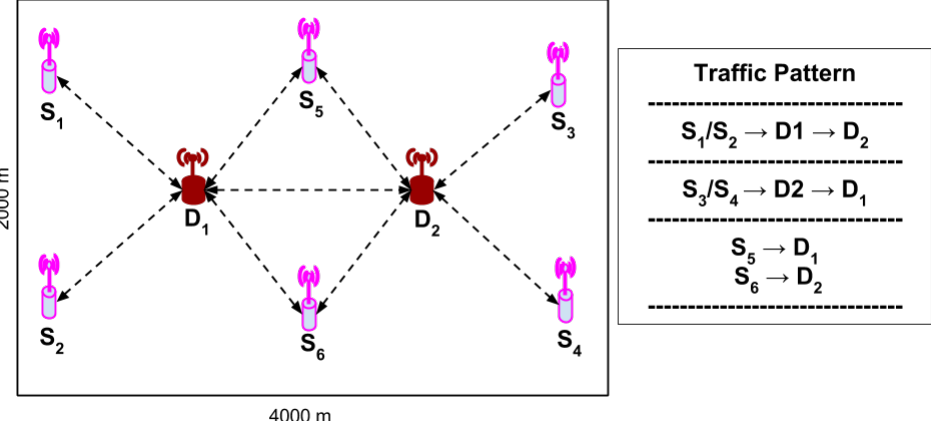
Figure 18. Multi-hop network with multiple sources, sinks and relays.